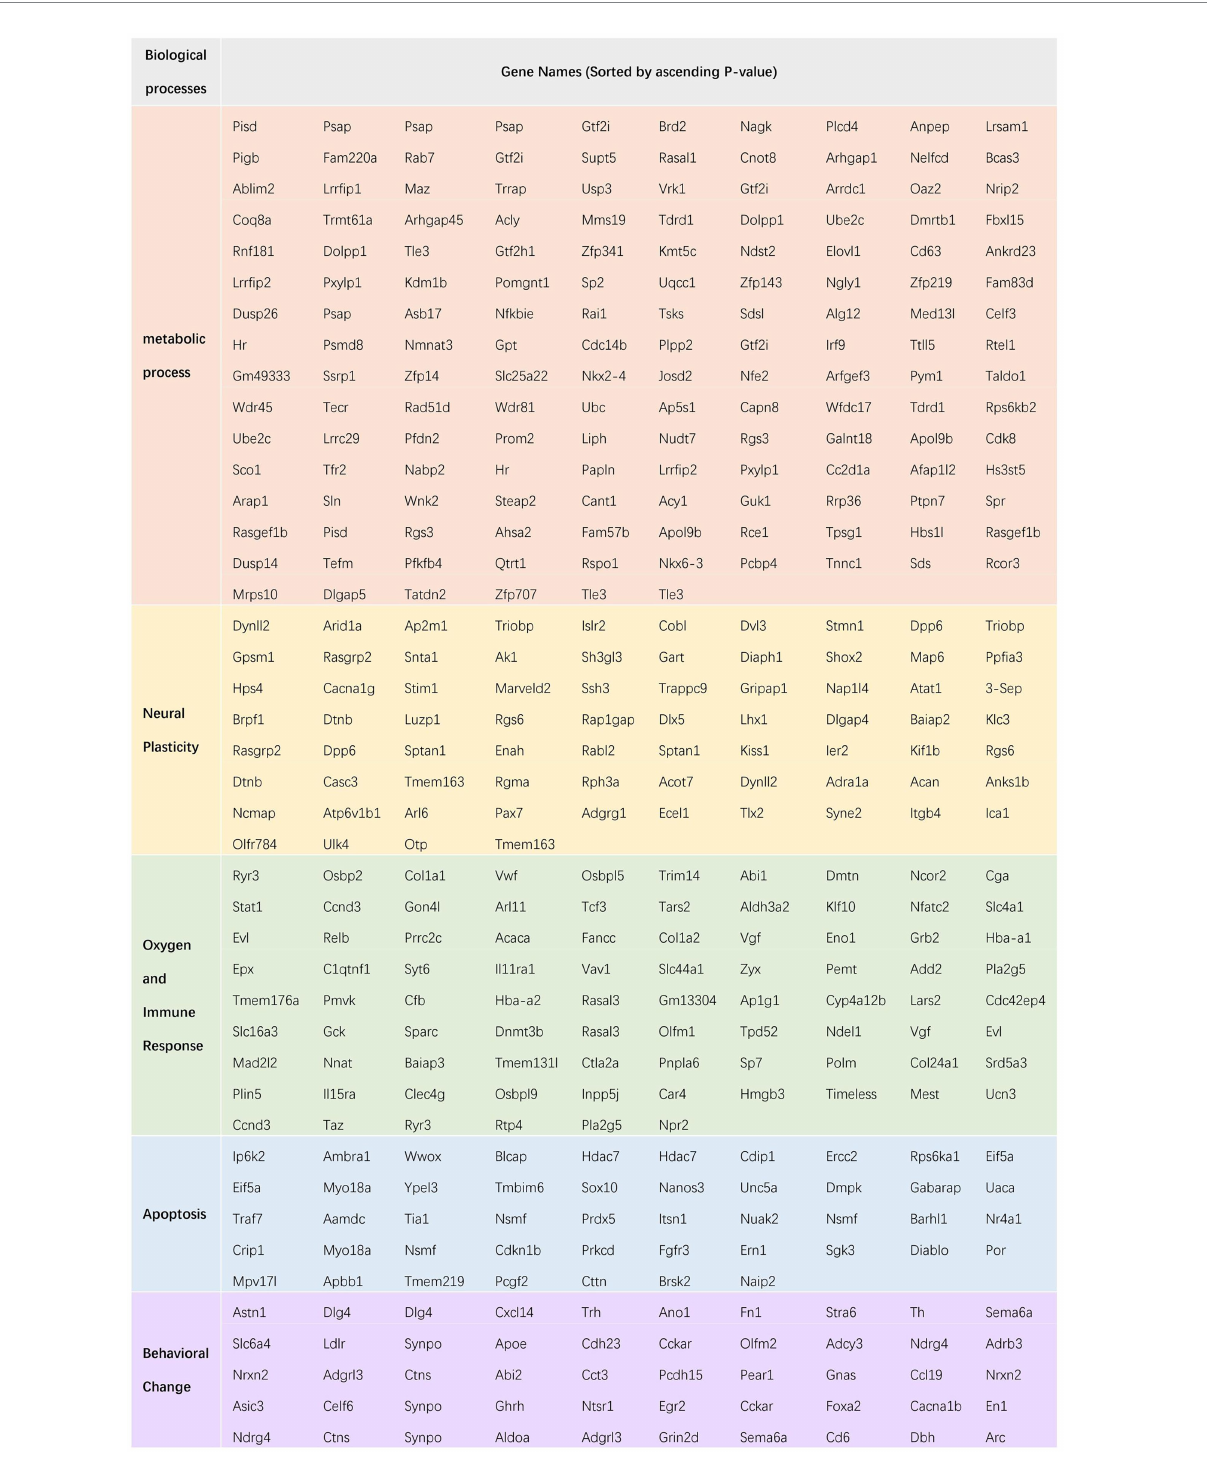
FIGURE 8 The name of genes encoded by the classified mRNAs in the ceRNA network was shown in the chart, sorted by ascending p value, from left to